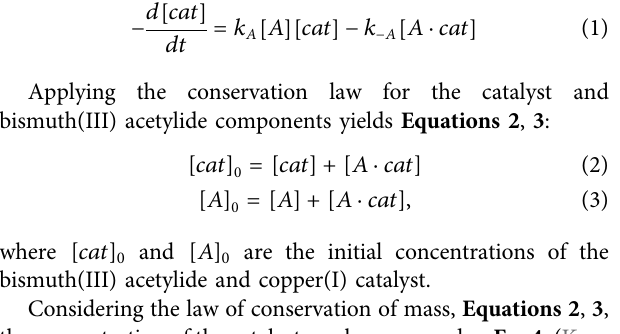
FIGURE6| Cyclicvoltammetry kineticstudies ofthecopper(I)catalyst in the 5-bismuth(III) triazolide formation at 25 ° C in dry DMSO recorded at 100 mV/sec. (A) Kinetic studies of [A [5] · cat] complex formation of the copper(I) catalyst and bismuth(III) acetylide (A [5]); (B) Kinetic studies of the azide ligation/migratory insertion and 5-bismuth(III)-triazolide, product formation. Conditions: 3-electrode cell with glassy carbon as the working electrode, copper foils as counter and reference